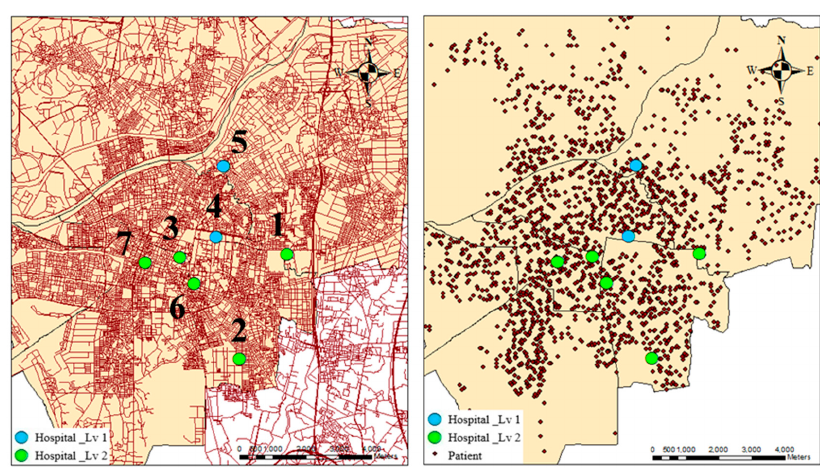
Figure 2. ( left ) Hospital network (level 1 (hospitals #4 and #5) indicates academic hospitals, and level 2 (hospitals #1, #2, #3, #6, and #7) means regional hospitals) and ( right ) patient patterns in Tainan